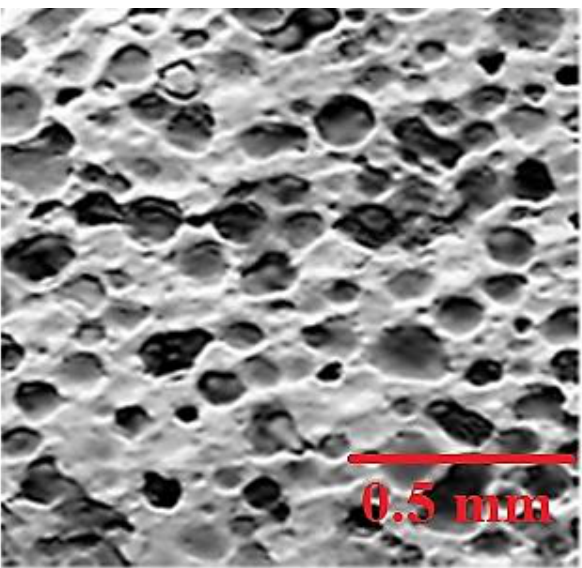
Figure 1. Photomicrograph of pumice sample showing pore size and distribution taken by binakuler microscope.